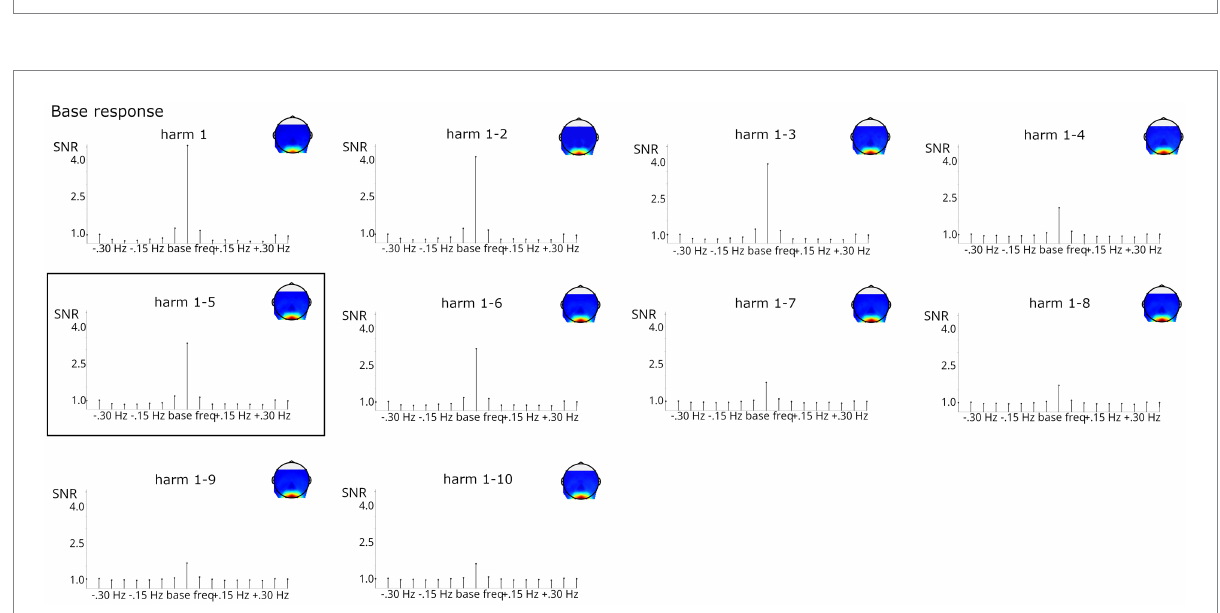
FIGURE 8 SNR of base grand-average responses summed across increasing numbers of harmonics (considering only the 1 st or up to harmonics 1–10). Highly significant responses were obtained in all analyses. The analysis on harmonics 1–5, marked by a black box, was indicated by the Z-score